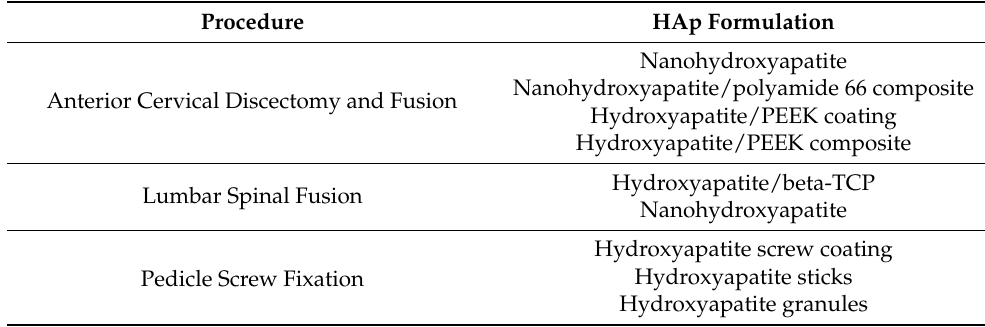
Table 2. Formulations of HAp used in spine